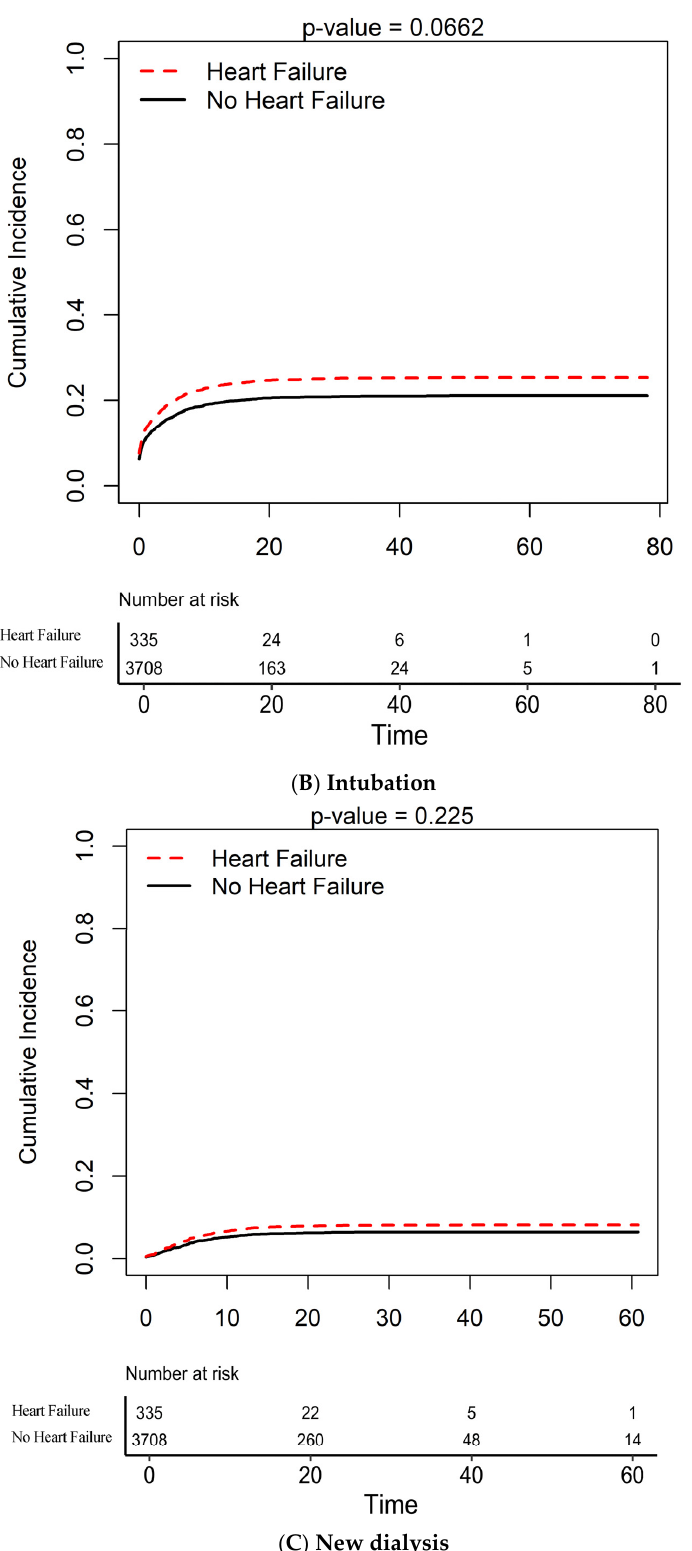
Figure 1. Cumulative incidence of in-hospital ( A ) mortality, ( B ) need for intubation, ( C ) need for intubation in heart failure and non-heart failure